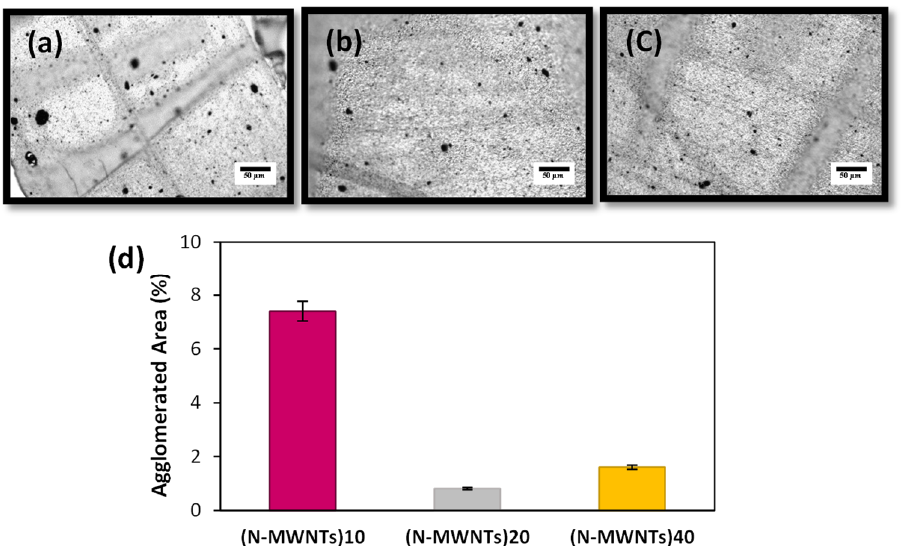
Figure 6. LM images of microtomed N-MWNTs/PVDF nanocomposites with 2.0 wt.% N-MWNTs synthesized at various catalyst concentration, ( a ) 10 wt.%, ( b ) 20 wt.%, ( c ) 40 wt.%, ( d ) Agglomerate area ratio of thin cuts of 2.0 wt.% N-MWNTs/PVDF nanocomposites.